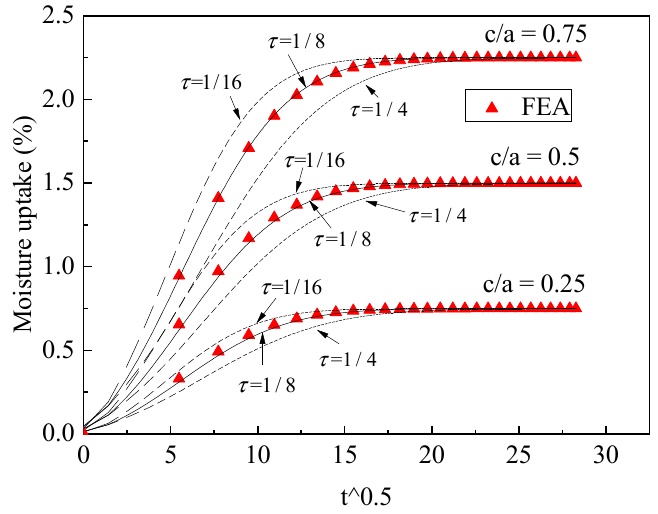
Figure 7. Validation of the three-phase diffusion model, D 1 < D 2 , c / a < 1.